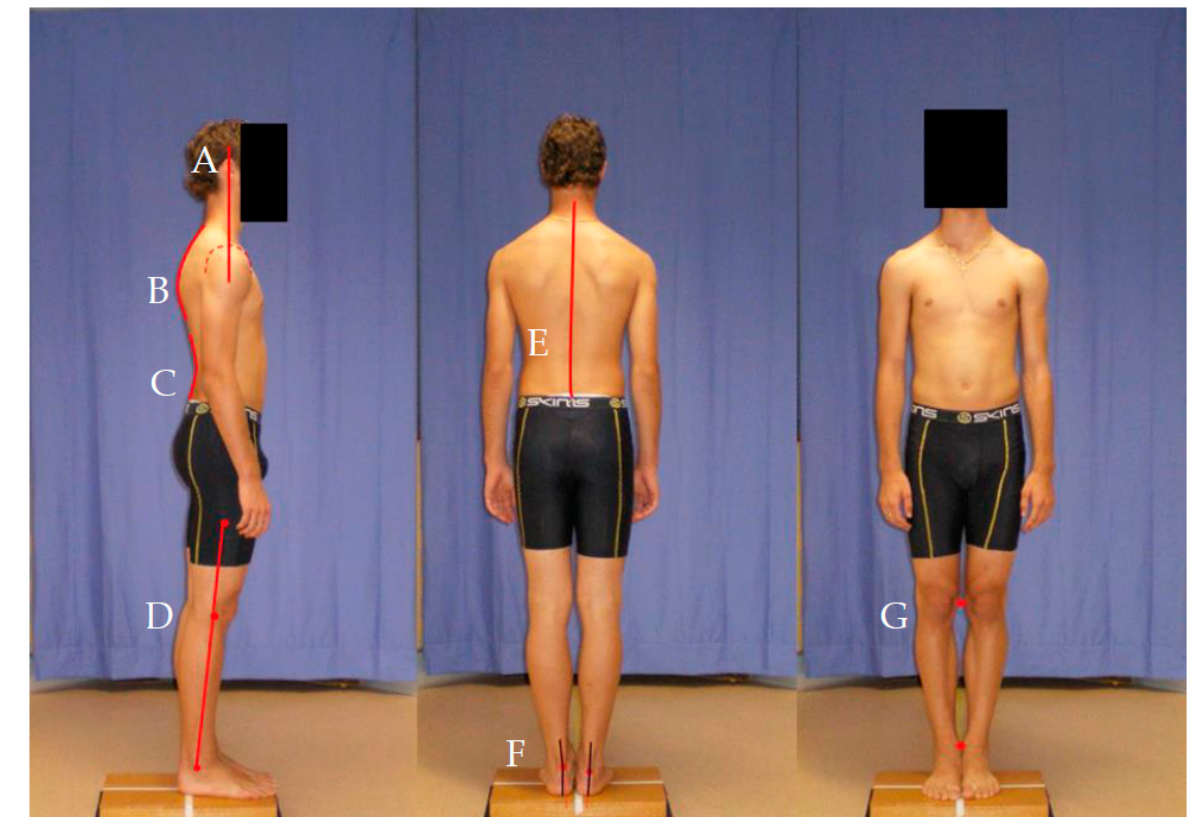
Figure 1. Posture assessment from a typical participant (from left to right): ( A ) Forward head: position of ear in relation to position of midline of shoulder; ( B ) thoracic kyphosis: observed hyperflexion of thoracic spine; ( C ) lumbar lordosis: hyperextension of lumbar spine as per Watson and Mac Donncha [29] scale; ( D ) lateral knee posture: based on vertical alignment of lateral malleolus, midline of knee joint, and greater trochanter. ( E ) Scoliosis C: observed left or right deviation from midline of spine; ( F ) rearfoot posture: angle between a line drawn through Achilles tendon and another through midline of the calcaneus. ( G ) Knee interspace: distances between medial femoral epicondyles and between medial malleoli.